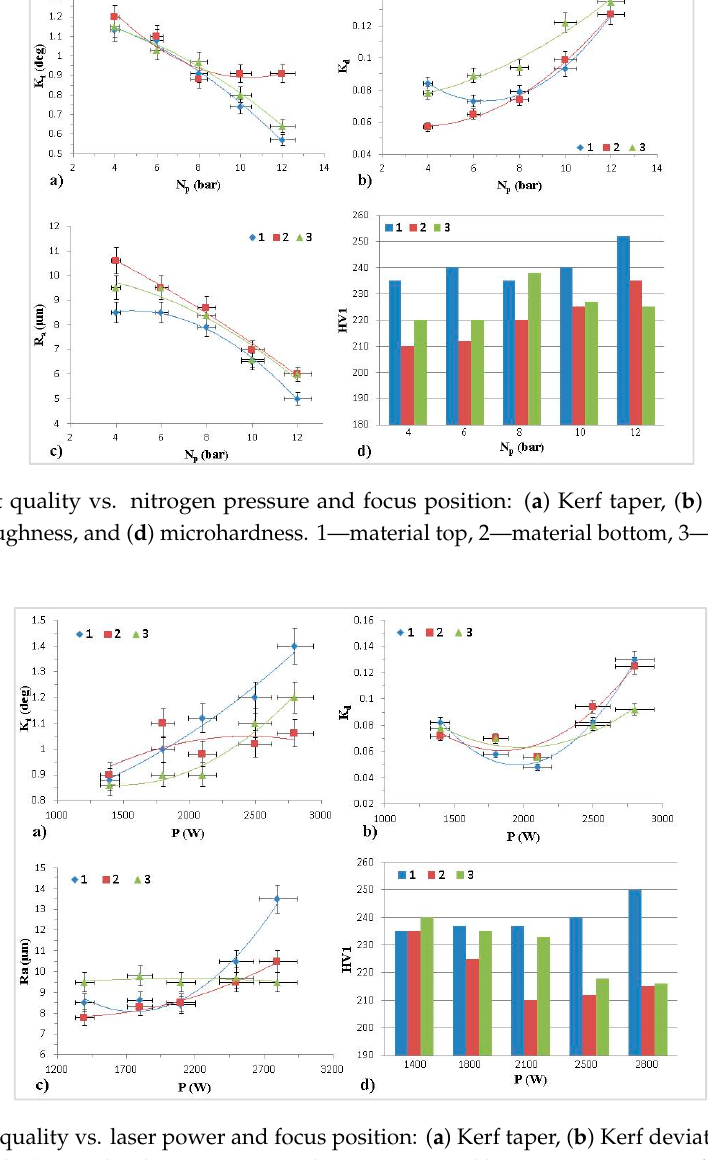
Figure 6. Cut quality vs. cutting speed and focus position: ( a ) Kerf taper, ( b ) Kerf deviation, ( c ) average roughness, and ( d ) microhardness. 1—material top, 2—material bottom, 3—0.5 mm in front of material. The solution found by the best PSO was adopted as the optimal laser cutting parameters in processing Nimonic 263 sheets, 2 mm thickness: Np = 14 bar; f = 0.5 mm in front of the material; P = 2034 kW; v = 4000 mm/min, since the obtained process measure value is highly satisfactory ( γ = 0.900825). The experimental validation was performed using the above adopted setting; the microstructural characterization of the cut was studied and compared with a nonoptimized cut. The cut appearance before and after optimization is given in Figure 7a and 7b, respectively.